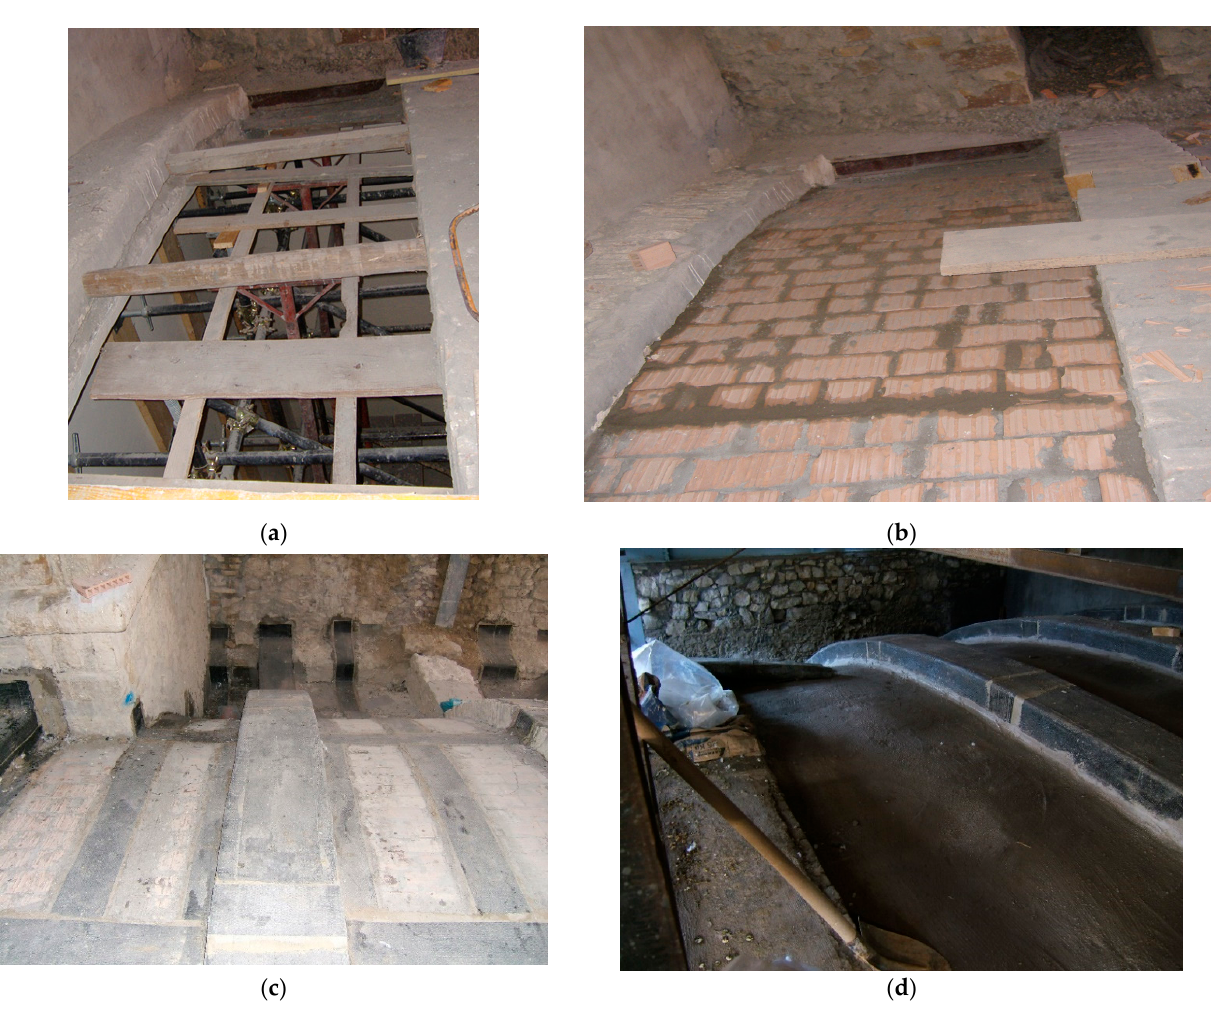
Figure 5. Composite strengthening of a partly collapsed ribbed barrel vault: ( a ) detail of the collapsed part; ( b ) reconstruction of the collapsed part; ( c ) detail of composite reinforcement; ( d ) detail of the completed intervention.